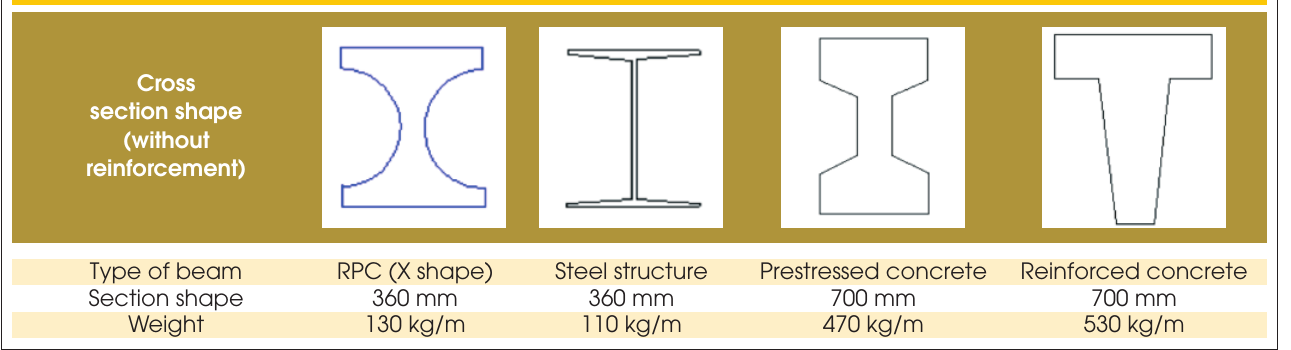
Table 1 – Section depth and weight comparison of different construction systems